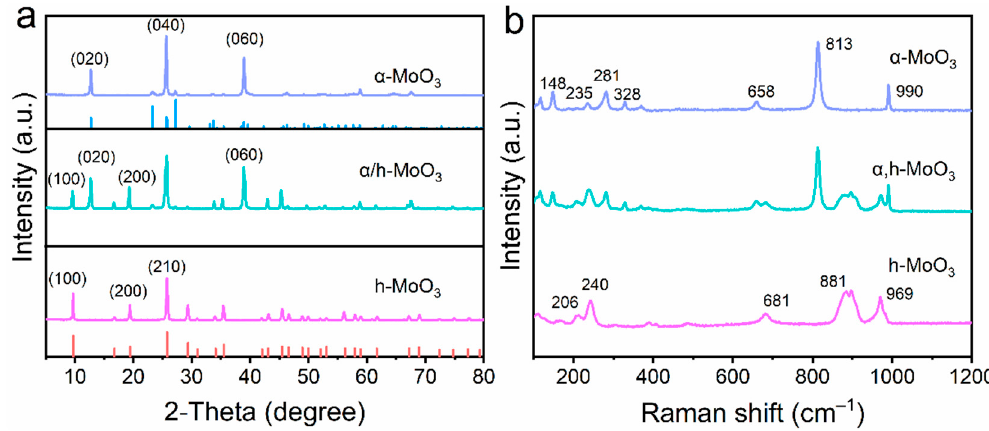
Figure 1. ( a ) XRD patterns and ( b ) Raman spectra of Sample A: h-MoO 3 , Sample B: α /h-MoO 3 , and Sample C: α -MoO 3 .